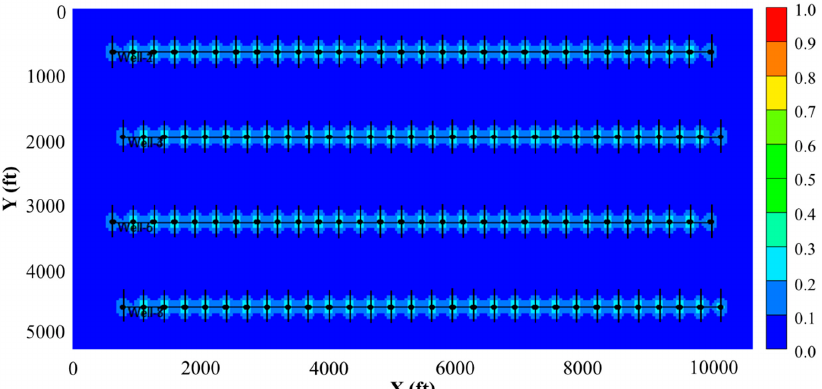
Figure 12. Distribution of CO 2 mole fraction for the case with molecular diffusion and adsorption.